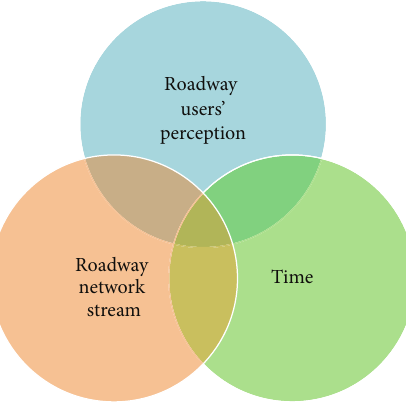
Figure 6: Congestion characterizing